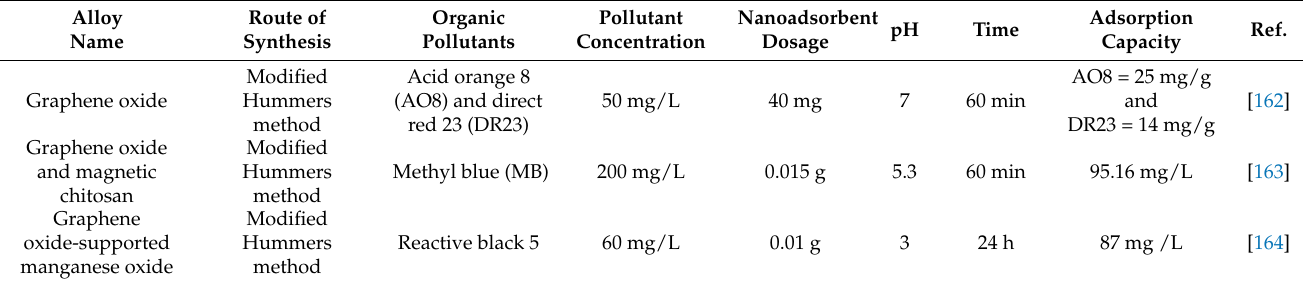
Table 6. Azo dye degradation with graphene oxide